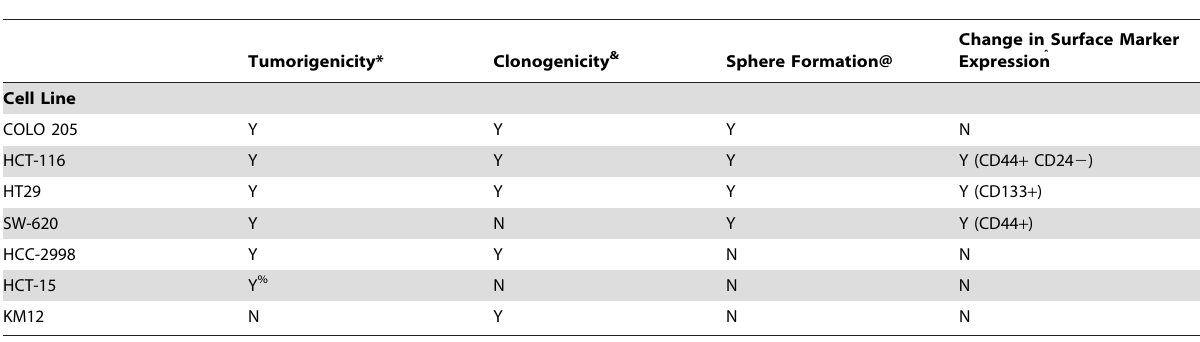
Table 4. Summary of SC-1 Effects in the NCI60 Colon Tumor